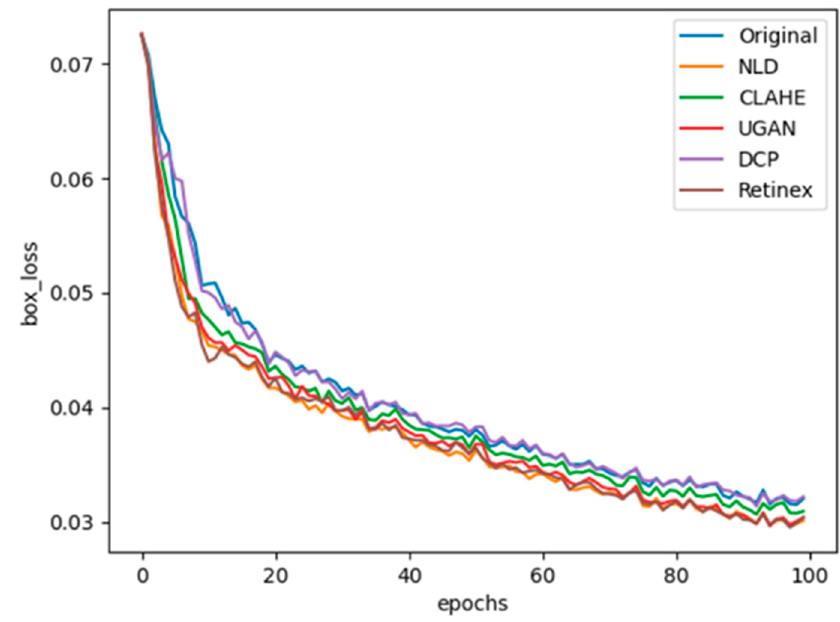
Figure 8. Train losses of image enhancement methods in YOLOv7.